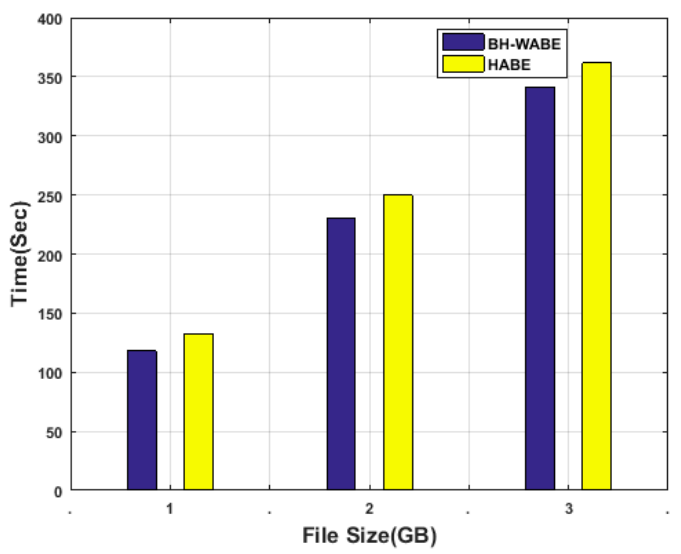
Figure 5. Computation time of encryption. HABE: hierarchical attribute-based encryption.